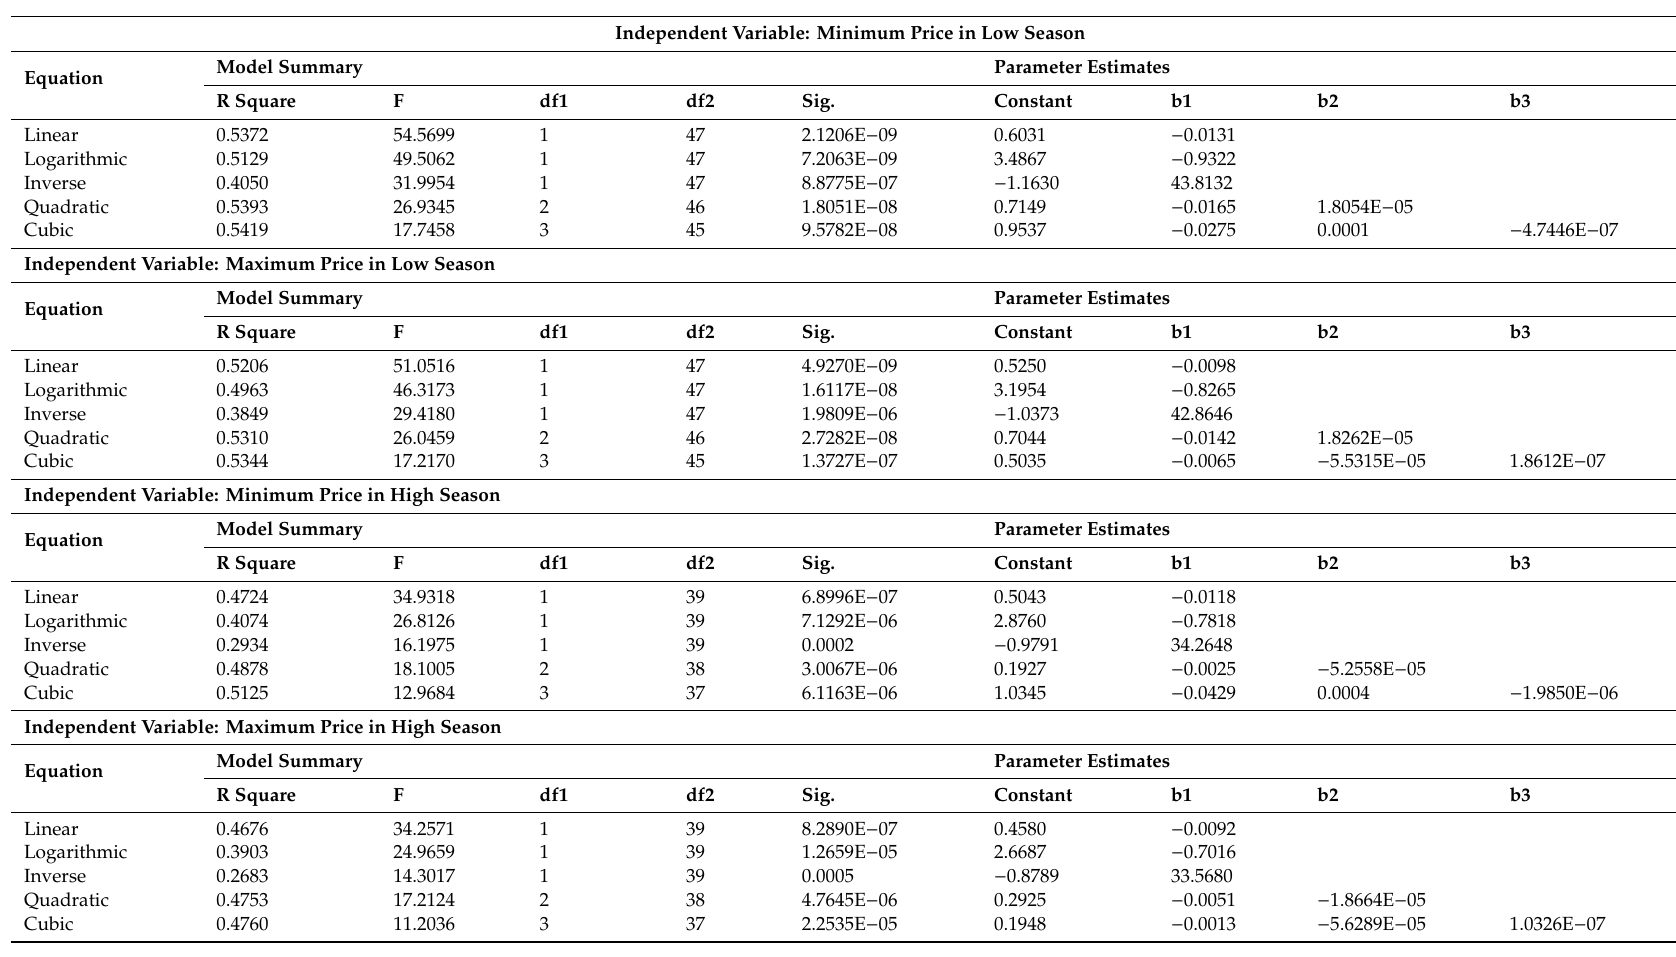
Table 13. Model summary and parameter estimates of regression analysis in Agadir destination with added value as dependent